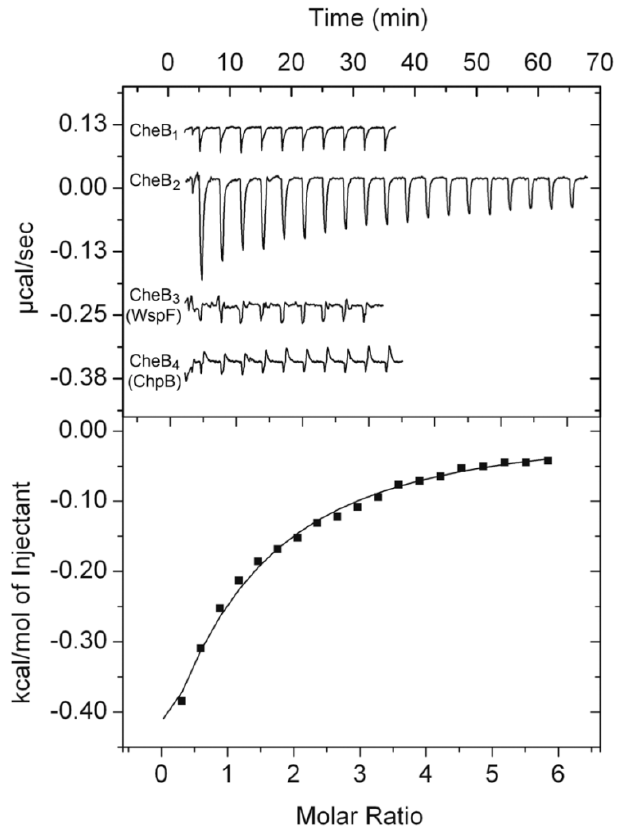
Figure 2. Specificity of the interaction between four CheB homologs of P. aeruginosa and the terminal pentapeptide GWEEF of the McpB chemoreceptor. Microcalorimetric titrations of the four CheB homologs (15 to 40 µM) with 14-µL aliquots (1 to 7 mM) of the GWEEF pentapeptide. Upper panel: raw titration data; lower panel: integrated, dilution heat-corrected and concentration-normalized peak areas of the titration data for CheB 2 . Data were fitted using the “one binding site model” of the MicroCal version of ORIGIN.